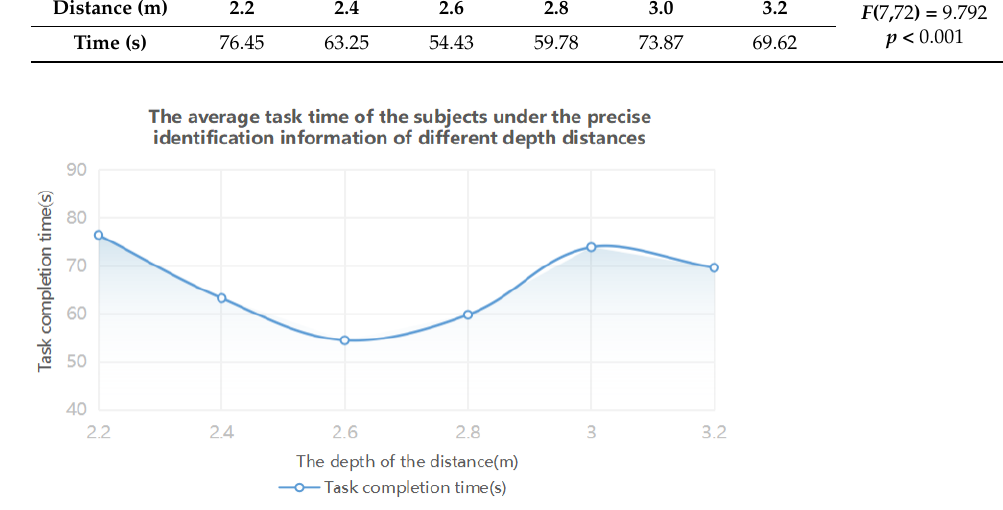
Figure 9. Time variation trend of the accurate identification information completing tasks at different depth distances. Table 7. Average eye movement data after the depth and distance range of the accurate identifica- tion information is divided.